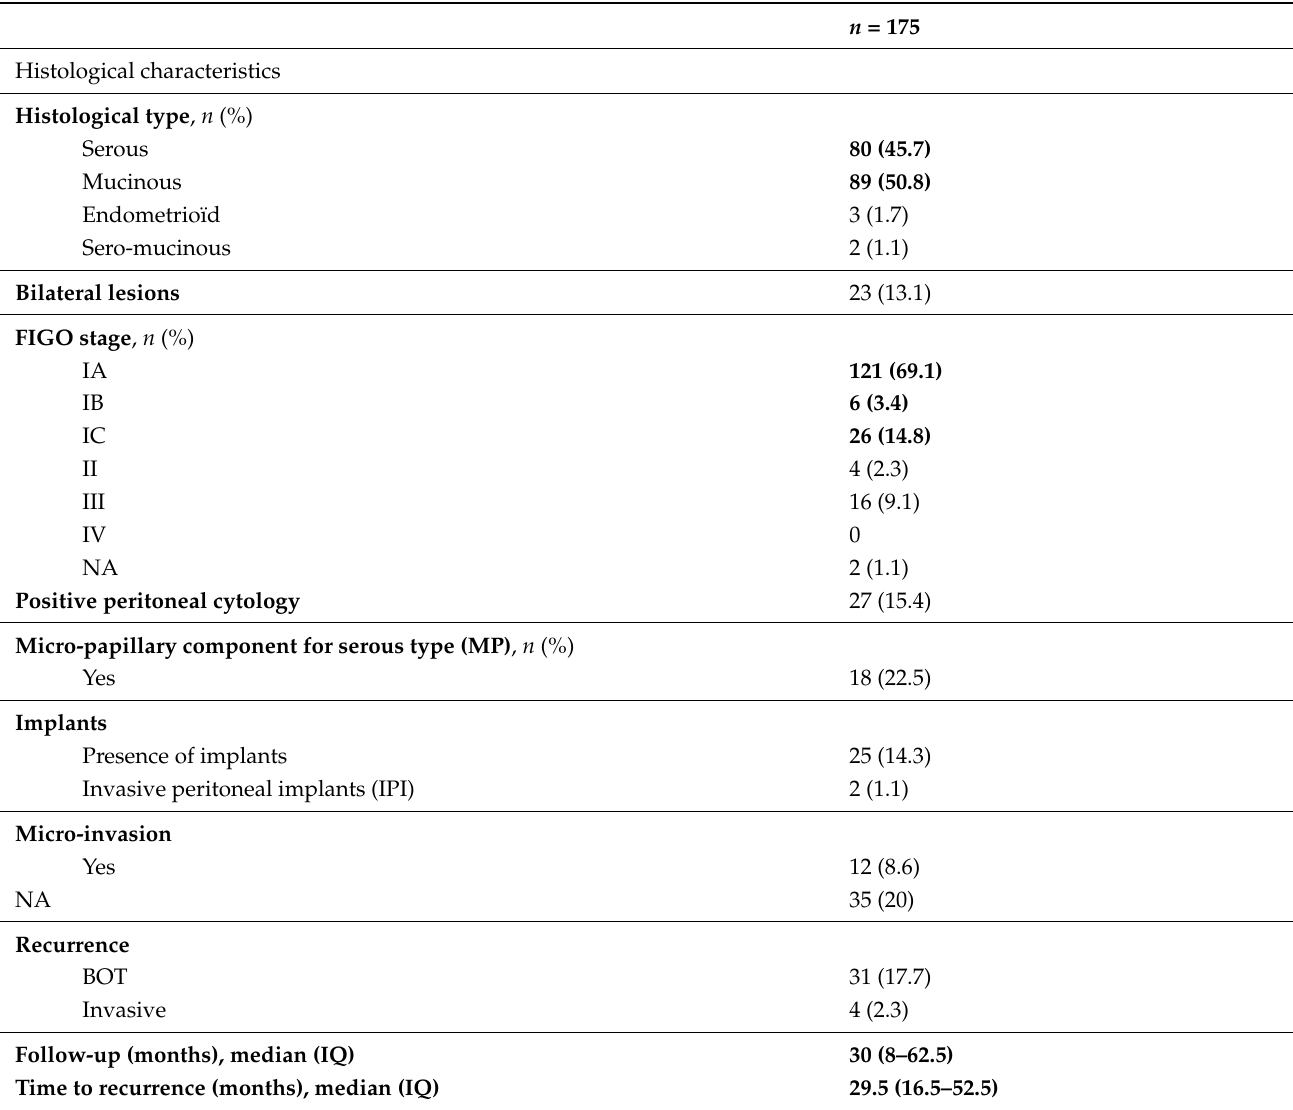
Table 2. Histological